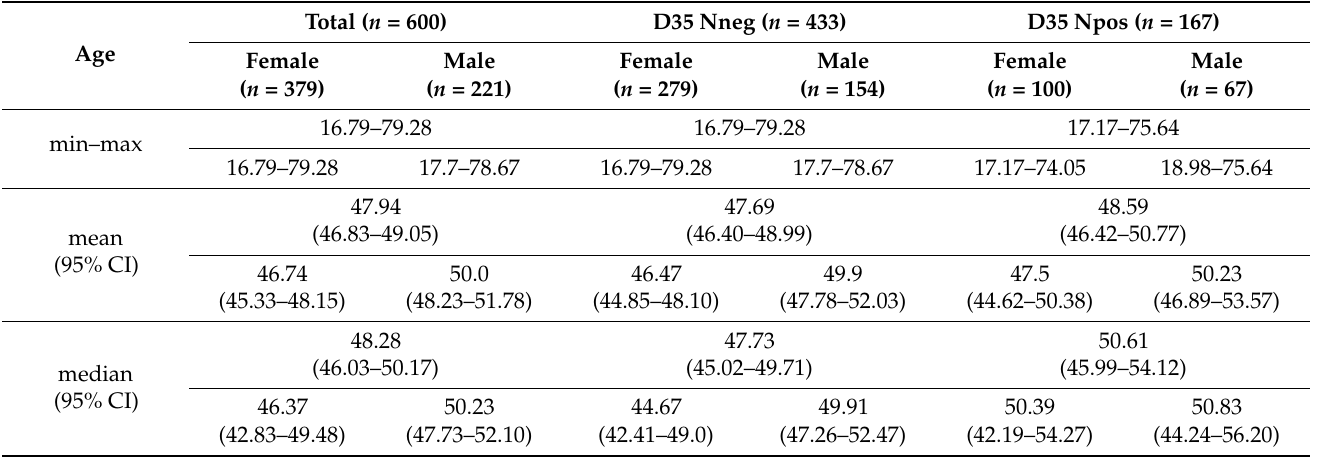
Table 1. Demographic characteristics of the study cohort. D35 Nneg and D35 Npos are individuals who tested negatively and positively, respectively, for N-specific antibodies 35 day after the second BNT162b2